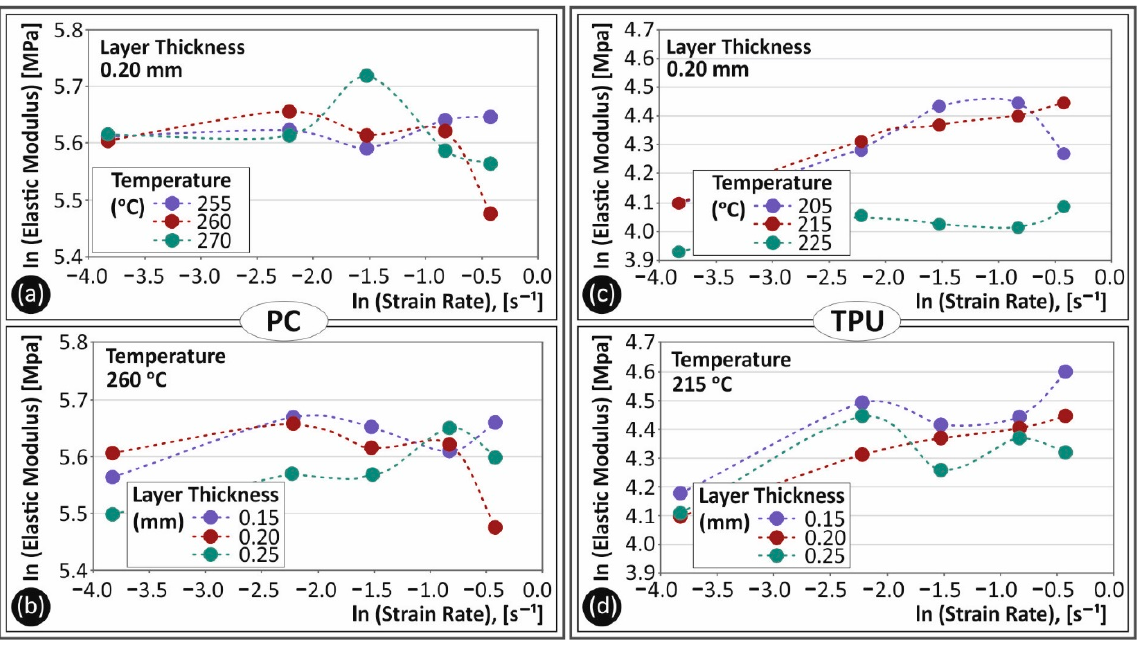
Figure 9. Ln calculated tensile elastic modulus (MPa) to strain rate (s − 1 ) for PC ( a , b ) and TPU ( c , d ) materials for the different temperatures ( a , c ) and the different layer heights ( b , d ) studied in this work.